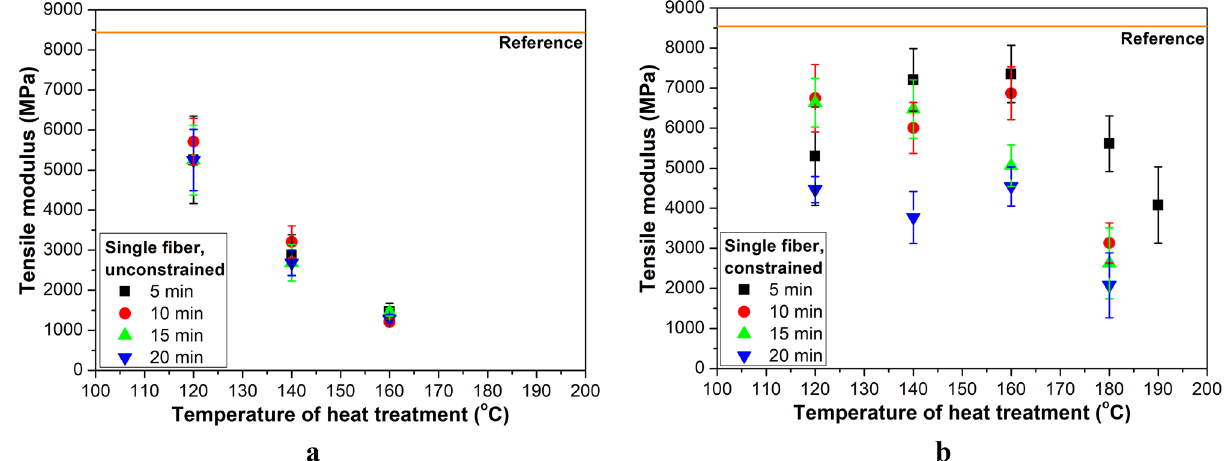
Figure 5. Tensile modulus of single fibers as a function of heat treatment temperature for different treatment times: in the case of free ( a ) and constrained ( b ) treatment.